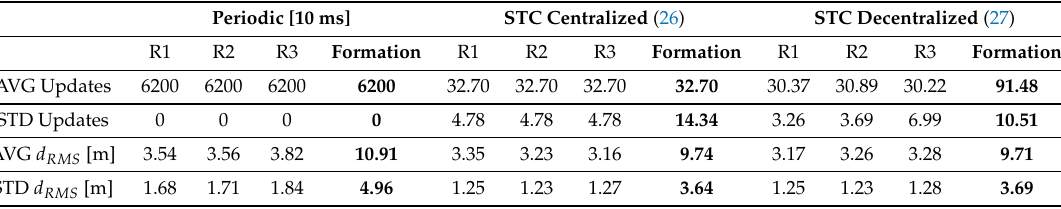
Table 2. Comparison of the average (AVG) and the standard deviation (STD) values of update number and RMS value of distance after 100 simulation results concerning the different control strategies for nonlinear, trajectory tracking: periodic implementation, STC with centralized triggering (26) and STC with decentralized triggering